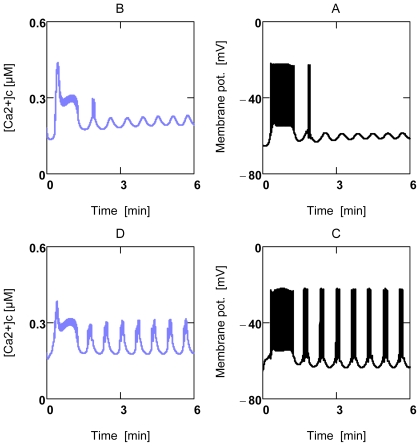
Effect of the PCr system in β-cells. Δcφ (A and C) and [Ca2+]c (B and D) in the presence of the PCr system, [Crtot] = 2.0 mM (A and B), [Crtot] = 0,5 mM (C and D)). Fluxes JAK and JCPK (A10 and A11) are added to a simulation taken from reference [10].